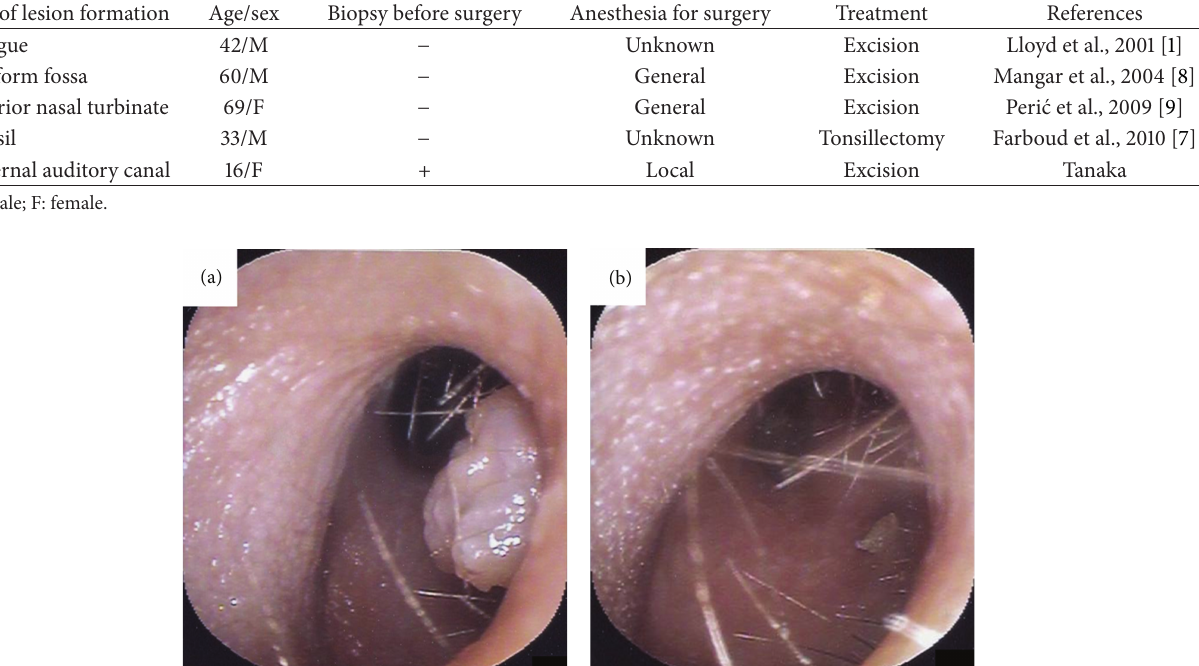
(Figure 2). Perivascular infiltration of lymphocytes or plasma cells was also found. Regarding the degree of papillary growth